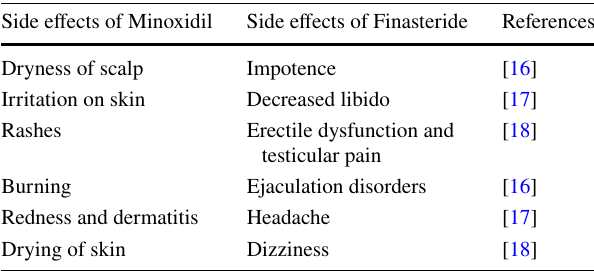
Table 1 Side effects of minoxidil and